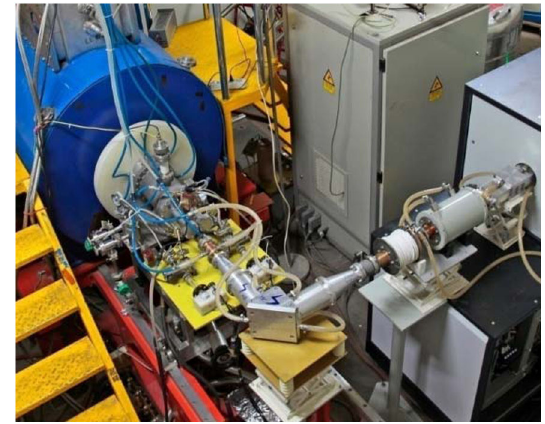
FIG. 3. Conventional components of the SECRAL source: (a) schematic view of the injection tank; (b) photo of the injection tank end.